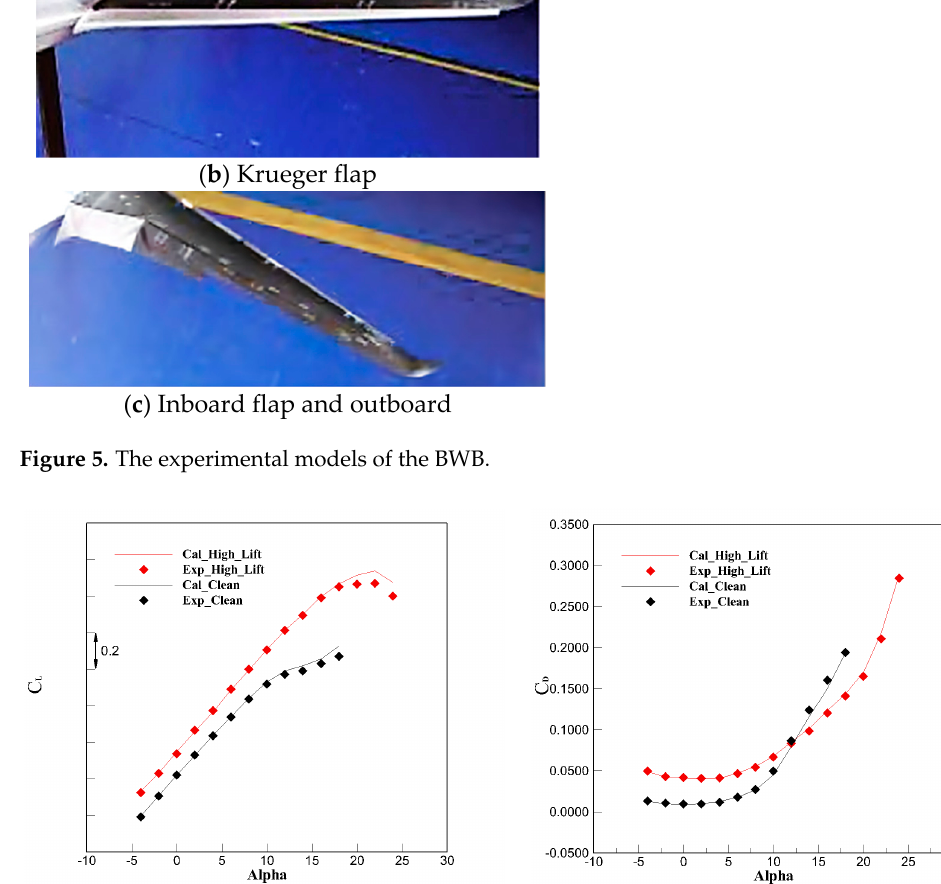
Figure 7. The surface flow of computation and experiment for the clean configuration.